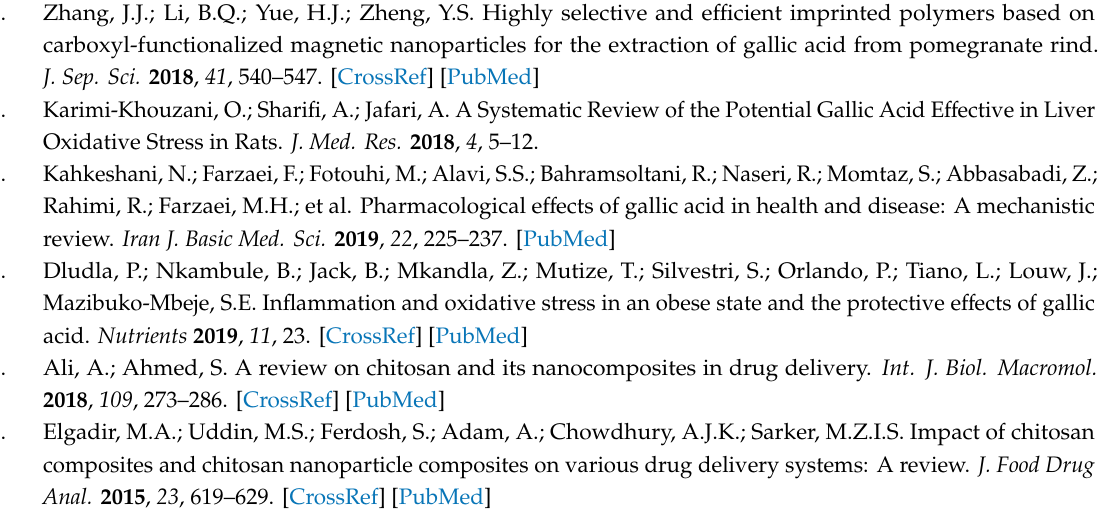
Table S1 Density ( ρ ), viscosity ( µ ), and conductivity ( σ ) of the three kinds of DESs at 293.15 K and atmospheric pressure (1.01 bar); Table S2 Independent variables their levels used for BBD; Table S3 Central composite experimental design with the independent variables; Table S4 Analysis of variance of the experimental results of the BBD; Table S5 Analysis of variance for the fitted quadratic polynomial model of extraction of GA; Figure S1. 1H NMR spectra of the HMICS (a) and NICS